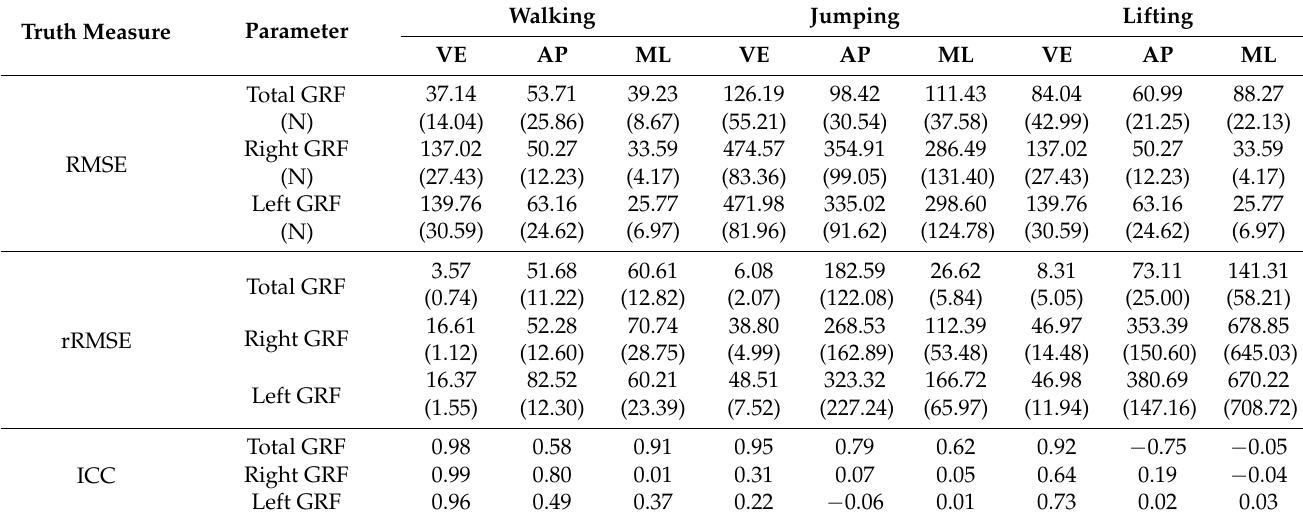
Table 1. The RMSE, rRMSE, and ICC values of the predicted total GRF components with respect to the measured total GRF components.